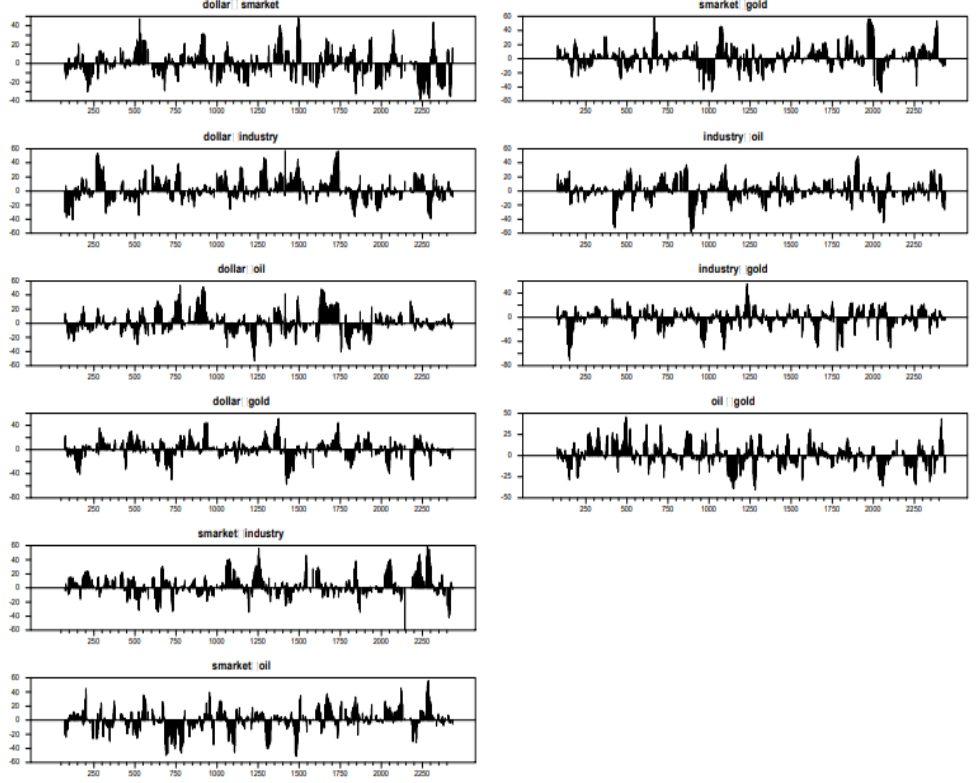
Figure 3. volatility spillover of